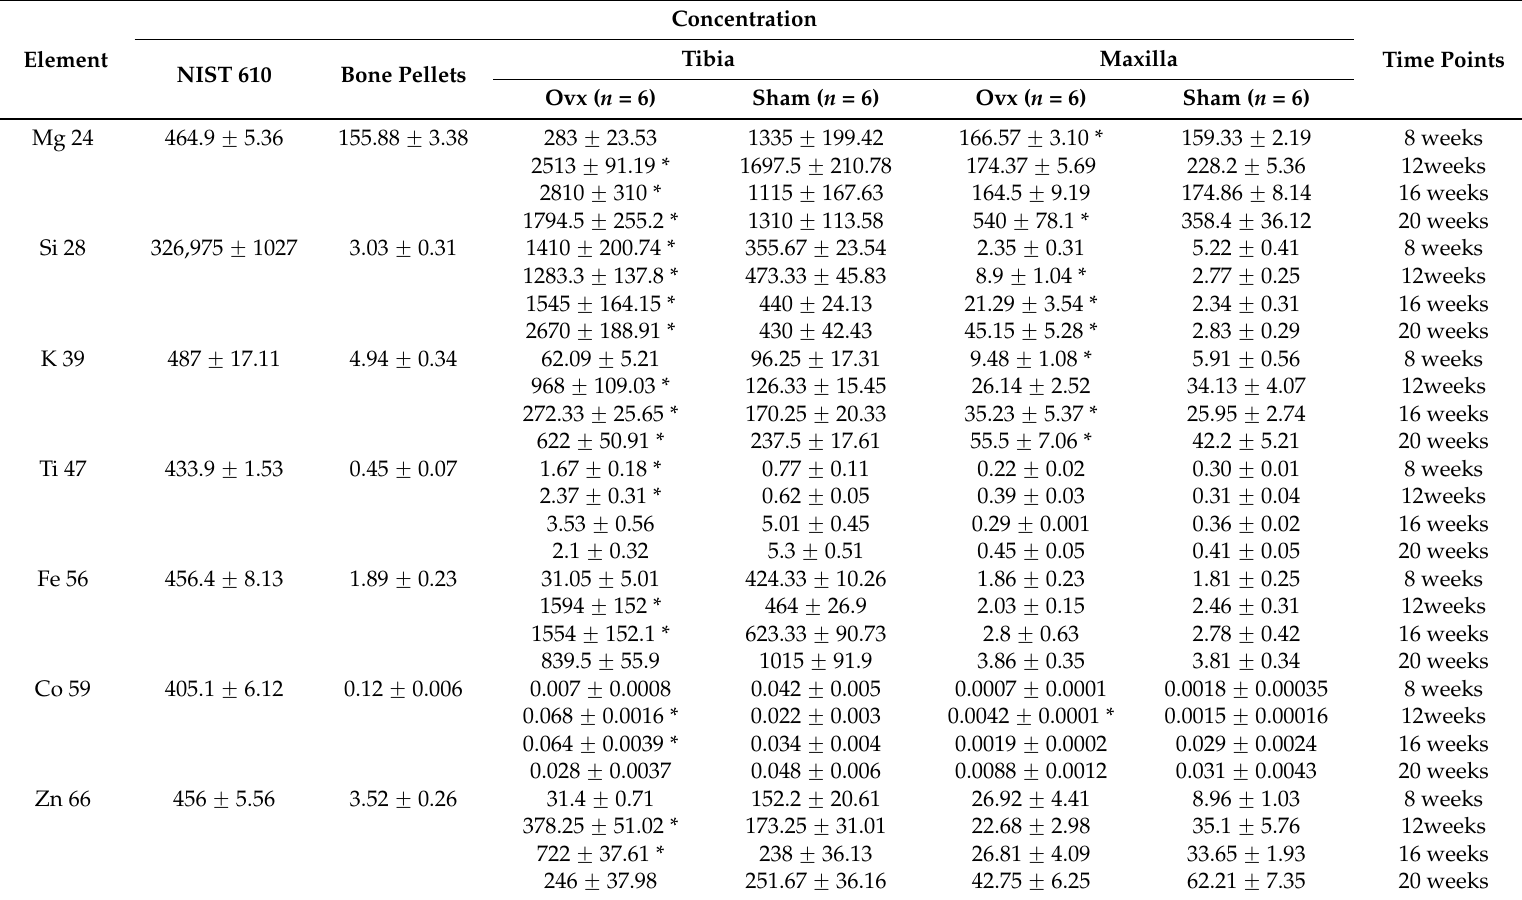
Table 1. The effect of Ovx on the average concentrations of atomic minerals on tibia and maxilla bones with time-course (* p < 0.05).